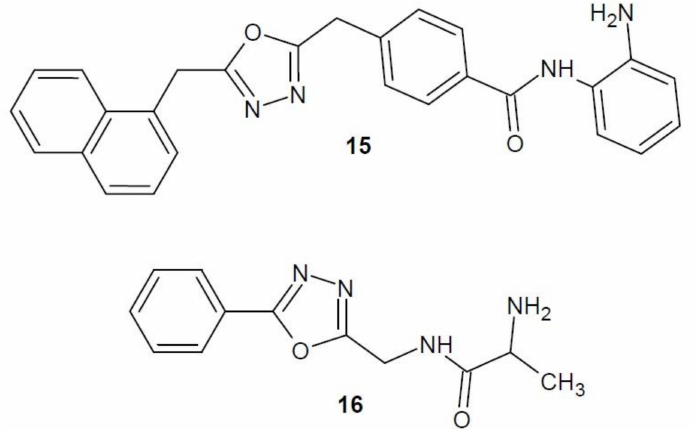
Figure 7. 1,3,4-Oxadiazole derivatives with activity of histone deacetylase inhibitors.